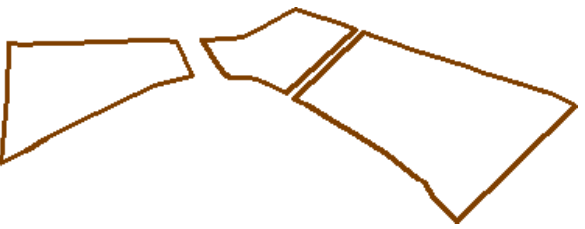
Figure 9: Virtual 3D model of the solid waste landfill - a view with the visualization of shelves and road (source: the authors’ own edition )